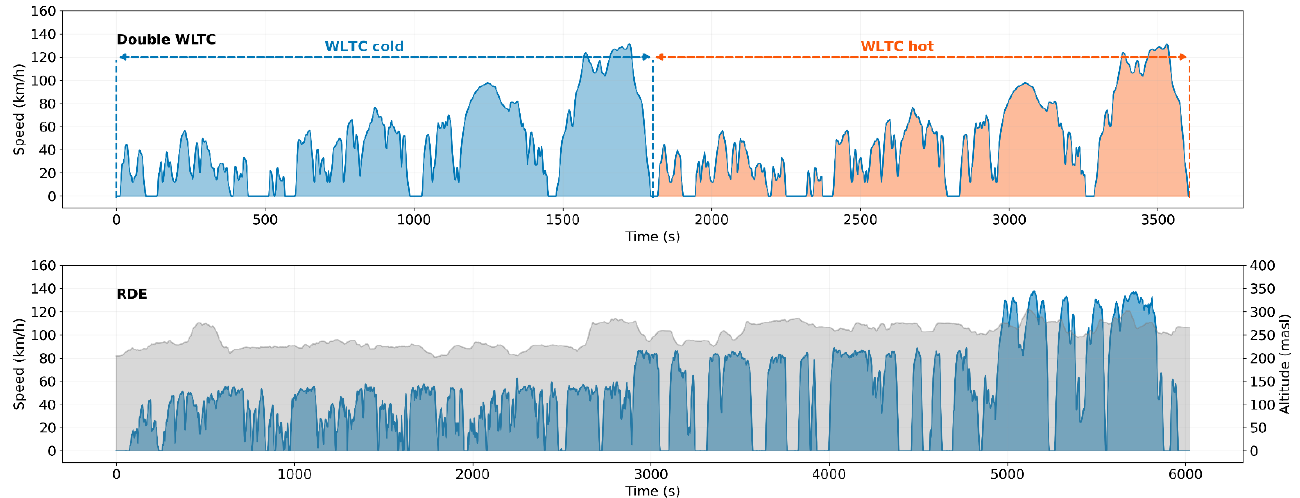
Figure 1. Speed profile of the double WLTC tests ( top panel ) and the on-road tests ( bottom panel ). The bottom panel’s shaded grey area indicates the altitude profile during the RDE test.